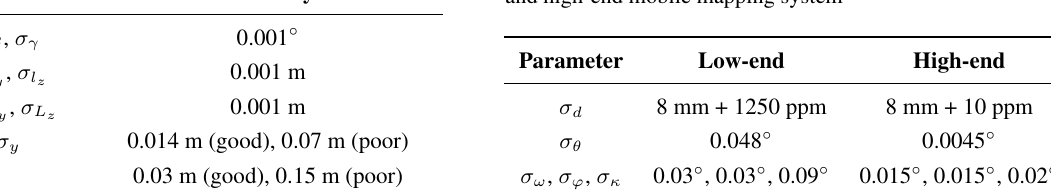
Table 3. System dependent accuracy parameters for